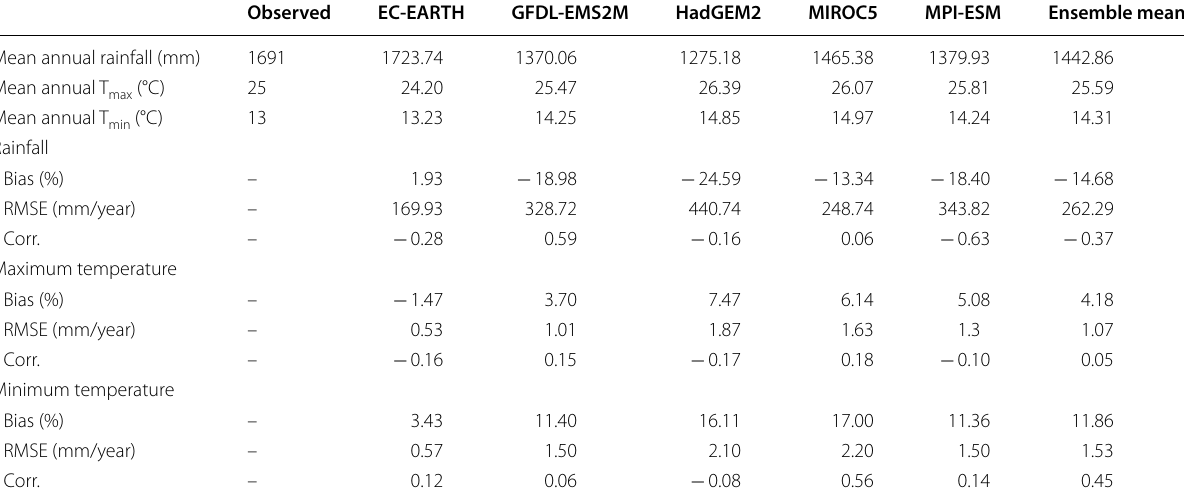
Table 1 Performance of the GCM–RCM models for DRB